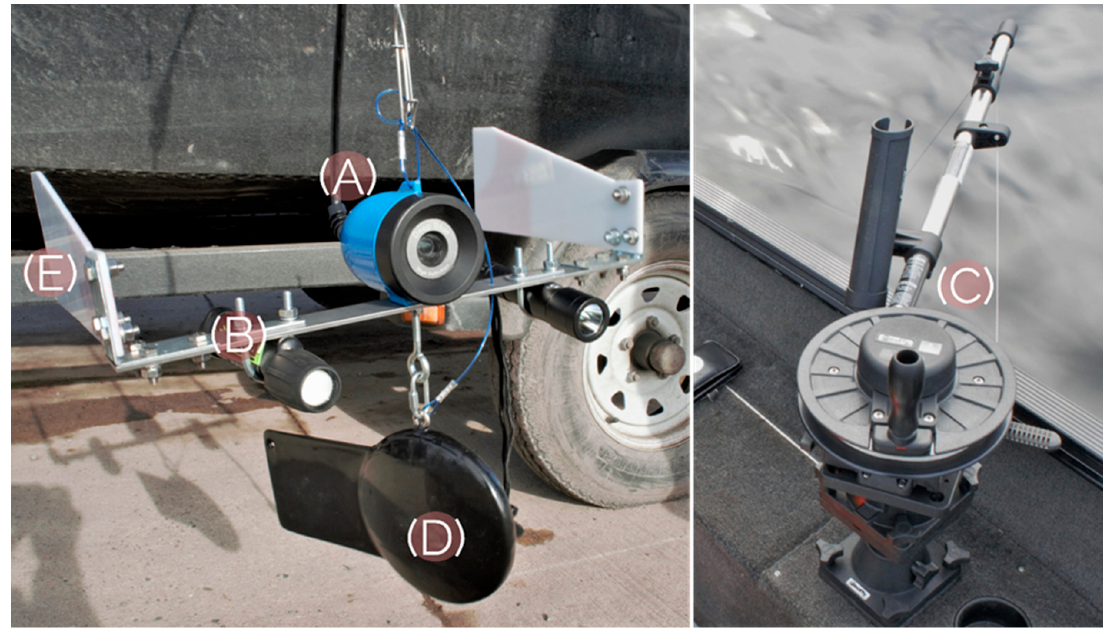
Figure 4. Underwater camera ( A ) setup. Two scuba diving flashlights ( B ) are used to facilitate filming close to the bottom. A downrigger ( C ) with a 10 lb weight ( D ) was used to lower the camera down and the fins ( E ) are designed to keep the camera facing parallel to the bottom.